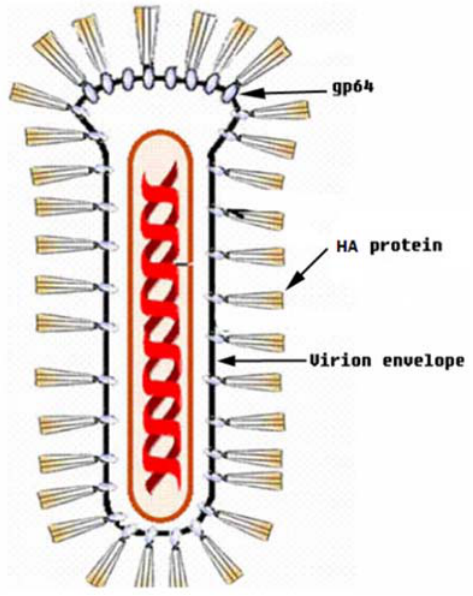
Figure 1. An ideograph of HA/gp64-fusion recombinant